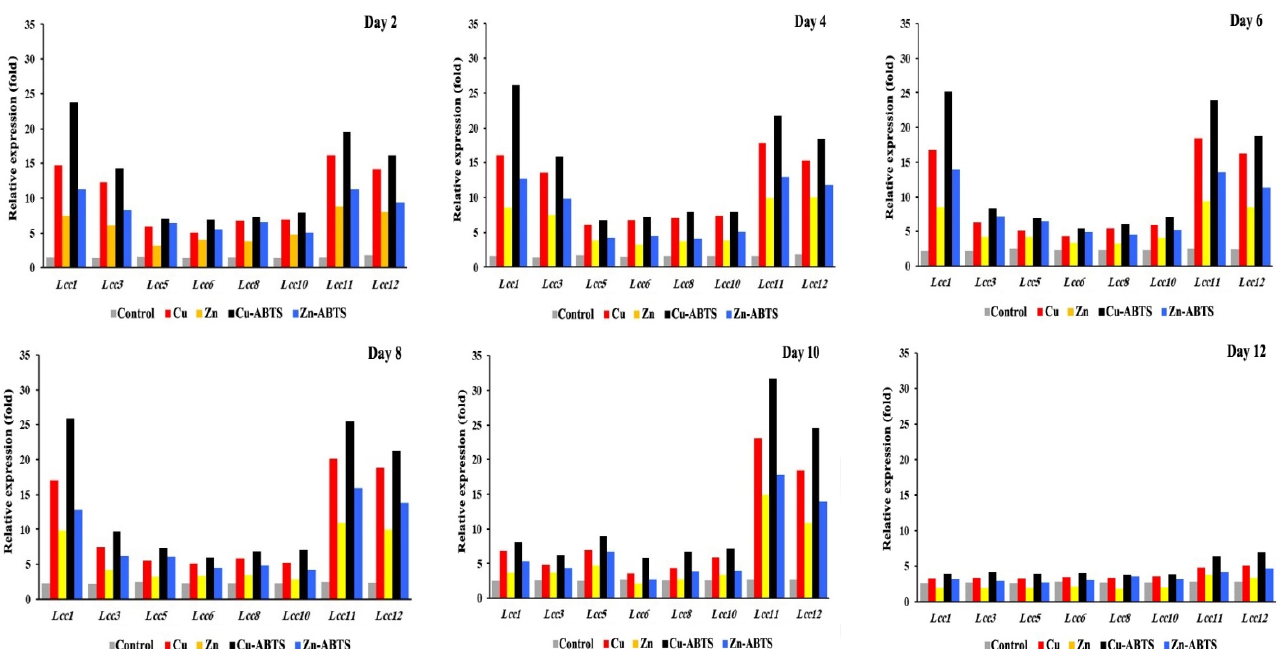
Figure 5. Transcription profile of laccase encoding genes during the growth of A. terreus KC46206 in the liquid cultures, supported by 1% crude oil at different growth times: 2nd day, 4th day, 6th day, 8th day, 10th day and 12th day. Fold-transcription is reported relative to the GAPDH gene of A. terreus KC46206.